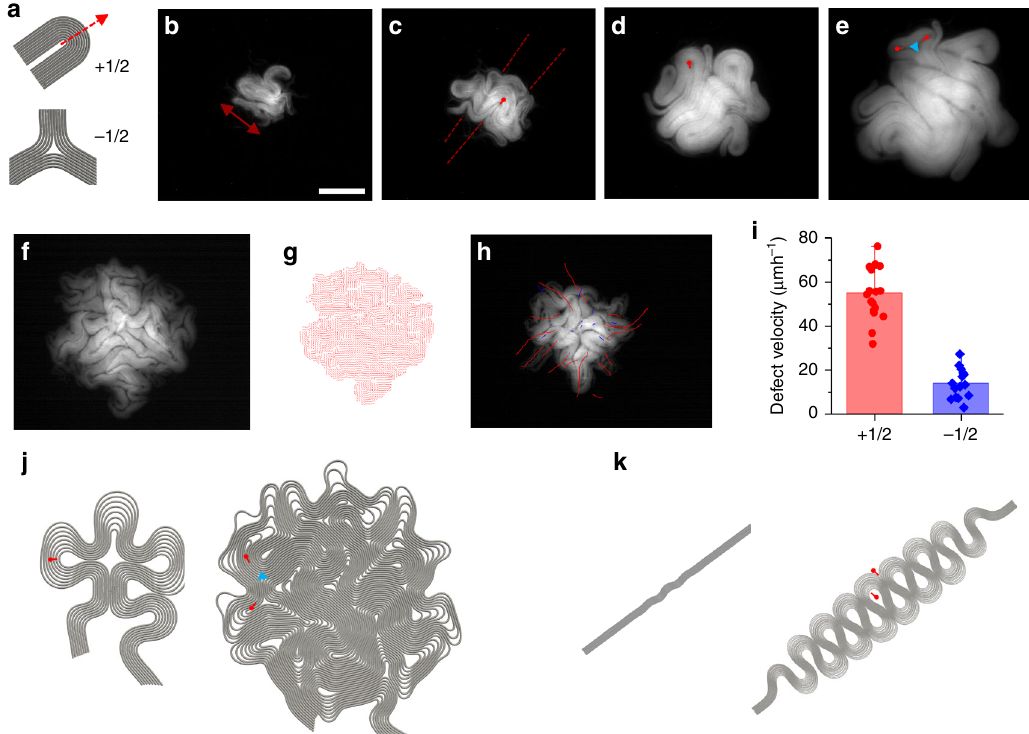
Fig. 4 Dynamics of topological defects. a Comet-like motile ( + 1/2) and trefoil-like ( − 1/2) topological defects. b – e Snapshots of a growing bio fi lm. b The bio fi lm elongates and reaches the critical buckling length. Scale bar 100 μ m. c As a result, the bio fi lm shows a structural folding and creates ( + 1/2) topological defects. d , e In total, ( + 1/2) topological defects at the edge move outward, split into two ( + 1/2) defects, and create a ( − 1/2) defect at the junction. f Snapshot of a growing bio fi lm. g The director fi eld of the bio fi lm ( f ). h Trajectories of both ( + 1/2) and ( − 1/2) defects. Red lines indicate the trajectories of ( + 1/2) defects which are motile, whereas blue lines represent the trajectories of ( − 1/2) defects, which are stationary. i Experimental data of velocity distribution of ( + 1/2) and ( − 1/2) defects. Error bars are de fi ned as s.d. j , k Simulation results of growing multilayered structures. j In total, the ( + 1/2) defect splits and forms paired ( + 1/2 red dots) and ( − 1/2 blue dot) defects. k Large colony folding forms only ( + 1/2) defects (red